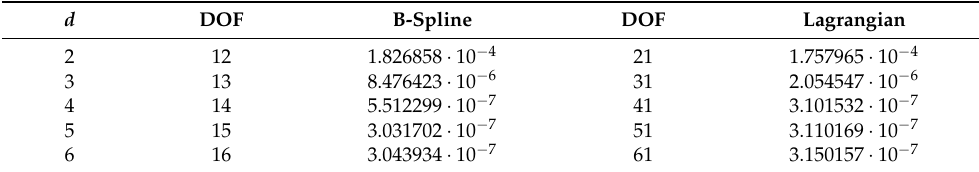
Table 7. Space-time energy norm squared (60), varying d and fixing ∆ t = 2 − d ∆ x